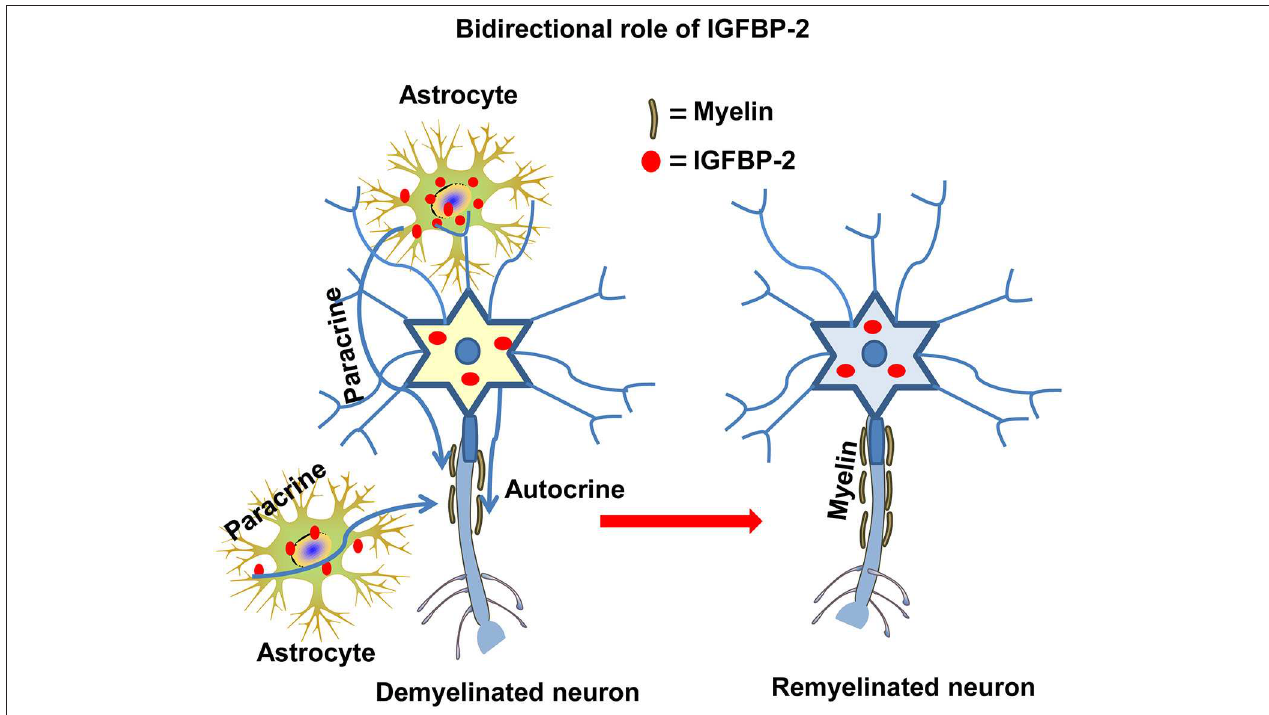
FIGURE 4 | The autocrine and paracrine action of IGFBP-2 in myelination. IGFBP-2 is involved in myelination and myelin repair via autocrine and paracrine mechanisms both in CNS and PNS neurons.